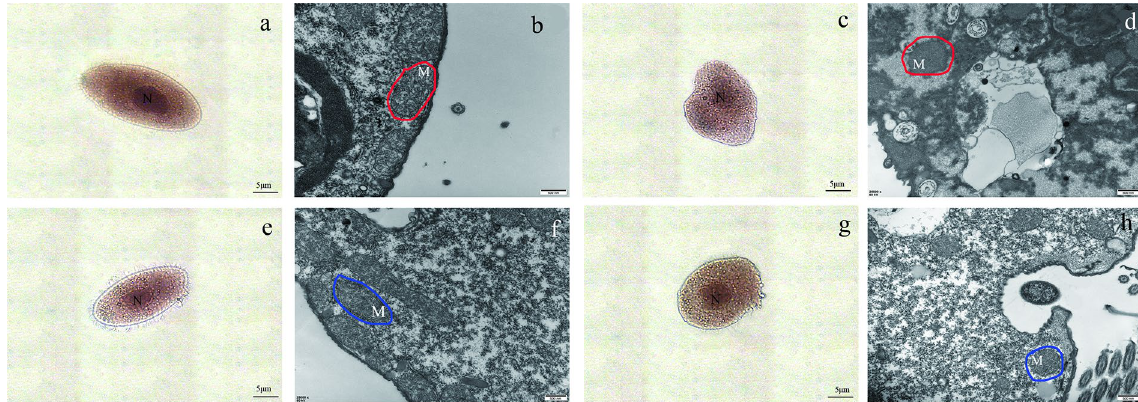
Figure 6. The observation of micromorphology and ultrastructure in control cells and experimental cells. ( a ) The ammonia silver staining of control group in the logarithmic phase. ( b ) The TEM observation of control group in the logarithmic phase. Mitochondria were circled by a red coil. ( c ) The ammonia silver staining of control group in the decline phase. ( d ) The TEM observation of control group in the decline phase. Mitochondria were circled by a red coil. ( e ) The ammonia silver staining of experimental group in the logarithmic phase. ( f ) The TEM observation of experimental group in the logarithmic phase. Mitochondria were circled by a blue coil. ( g ) The ammonia silver staining of experimental group in the decline phase. ( h ) The TEM observation of experimental group in the decline phase. Mitochondria were circled by a blue coil.